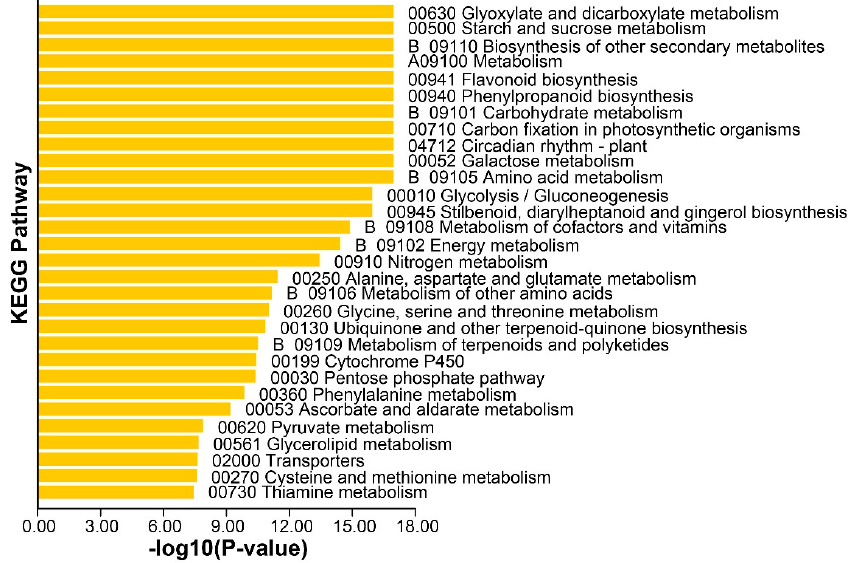
Figure 9. KEGG enrichment analysis of all differentially expressed genes (DEGs) in basil under heat stress.